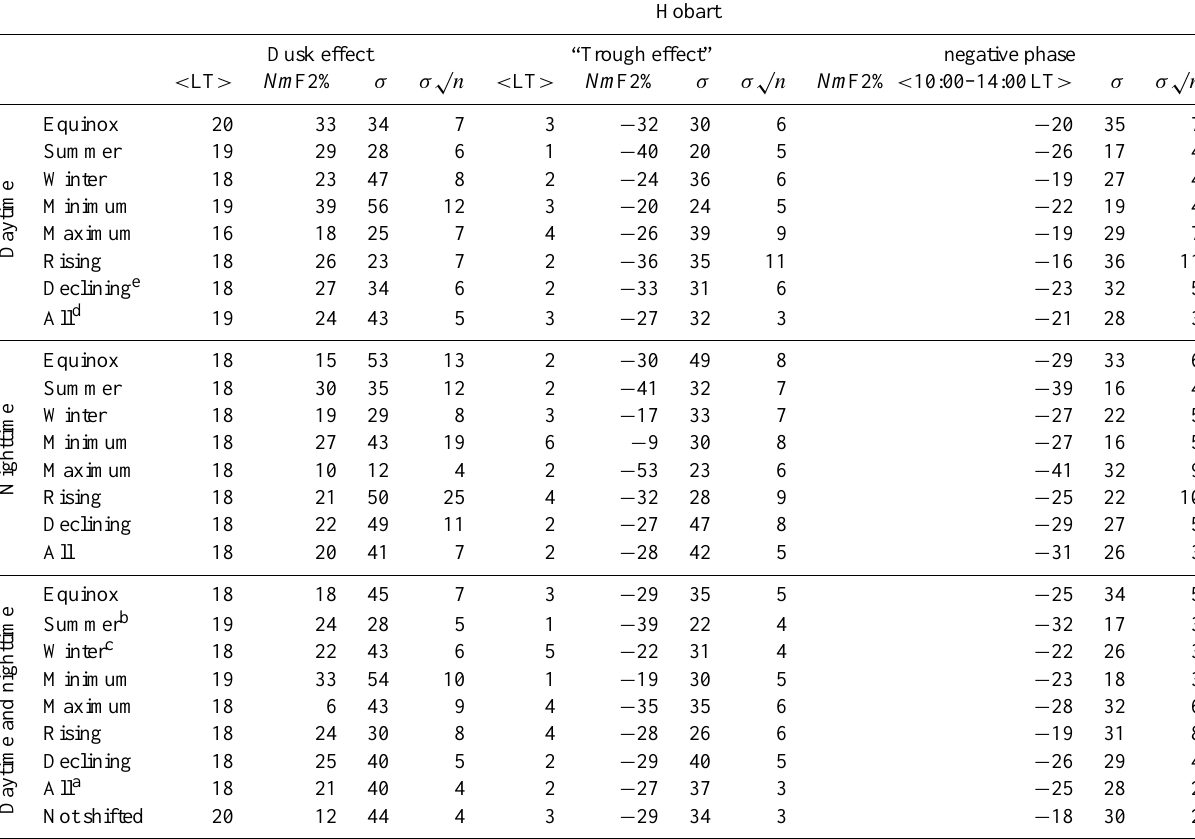
Table 3. Summary of ionospheric storm characteristic patterns for three common features seen at